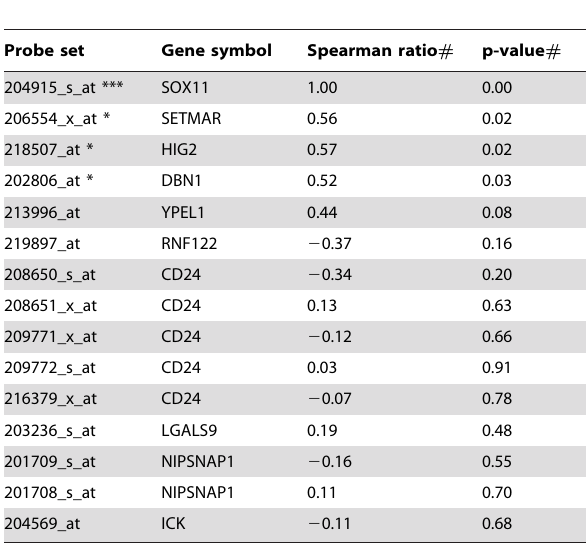
Table 2. Validation of SOX11 siRNA downregulated genes in a dataset of 16 primary MCL a)